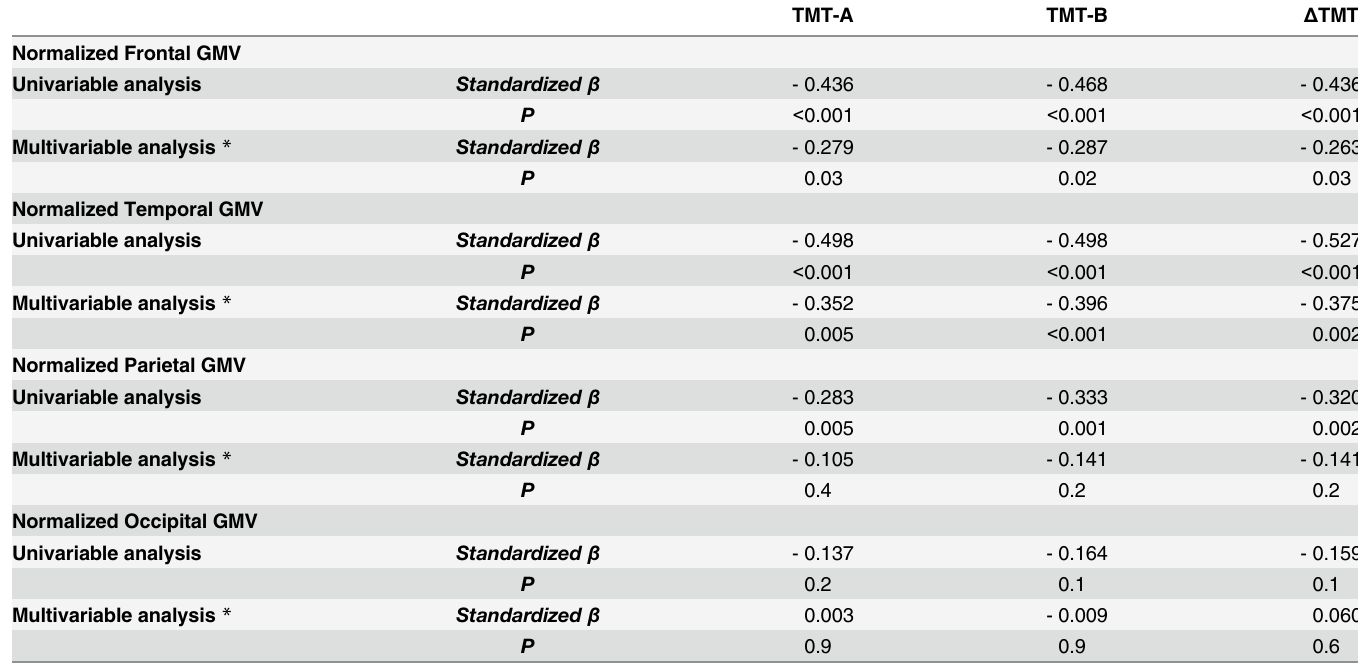
Table 6. Univariable and Multivariable-Adjusted Regression Analyses of Correlation between Normalized Regional GMV and TMT. Abbreviations: GMV, gray matter volume; TMT, Trail Making